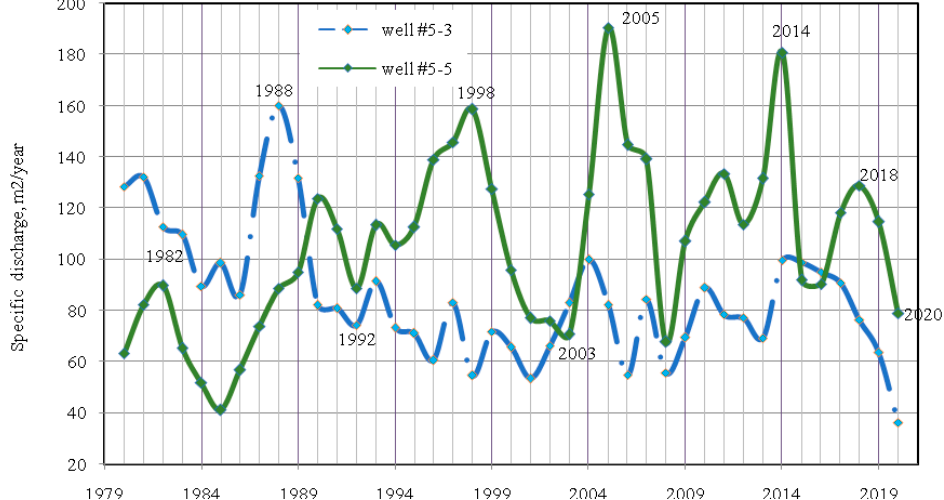
Figure 9. Chronological graph of variability of values of specific rate of groundwater discharge to the Southern Bug River, m 3 year − 1 per running meter of the length of the river for the period 1980–2017 in the range of the Khmilnyk city, with the allocation of maxima having a 5–6 and 10–11 periodicity for well #5-3 and 7–8-year frequency for well #5-5.